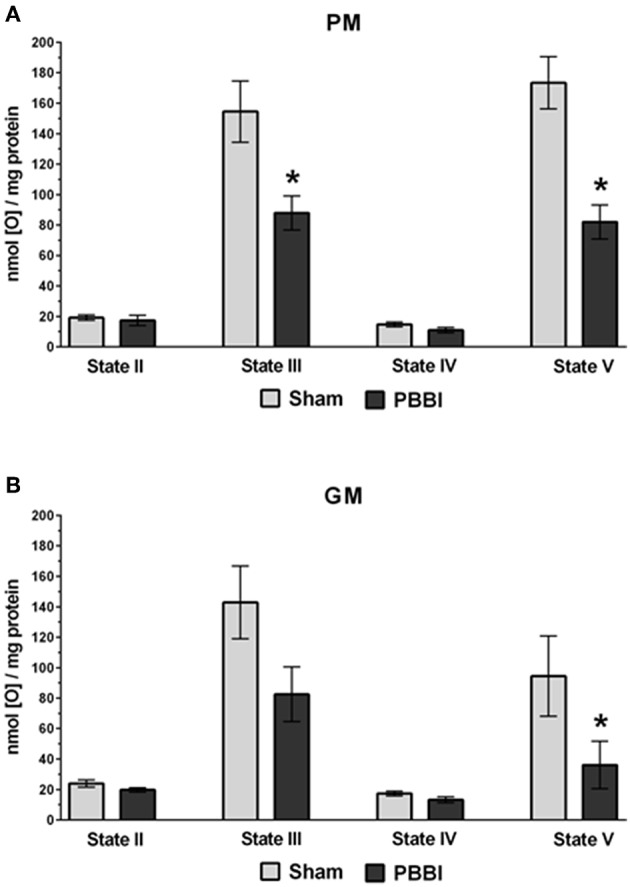
Decreased ATP synthesis in the presence of metabolic substrates PM and GM following PBBI. (A,B) At 24 h post-PBBI or sham injury, mitochondrial respiration rates were measured using Clark-type oxygen electrode in the presence of metabolic substrates PM and GM. PBBI reduced ATP synthesis (State III) with PM (43%, *p < 0.05) and GM (42%, p = 0.08 non-significant). No change in basal respiration (State II) and proton leaks (State IV) rates were observed. The FCCP induced uncoupling rates (State V) with PM and GM were significantly reduced in the PBBI group (53–62%, *p < 0.05). Bars represent group means ± SEM (n = 5 animals / group). *p < 0.05 compared to sham injured group (unpaired t-test).